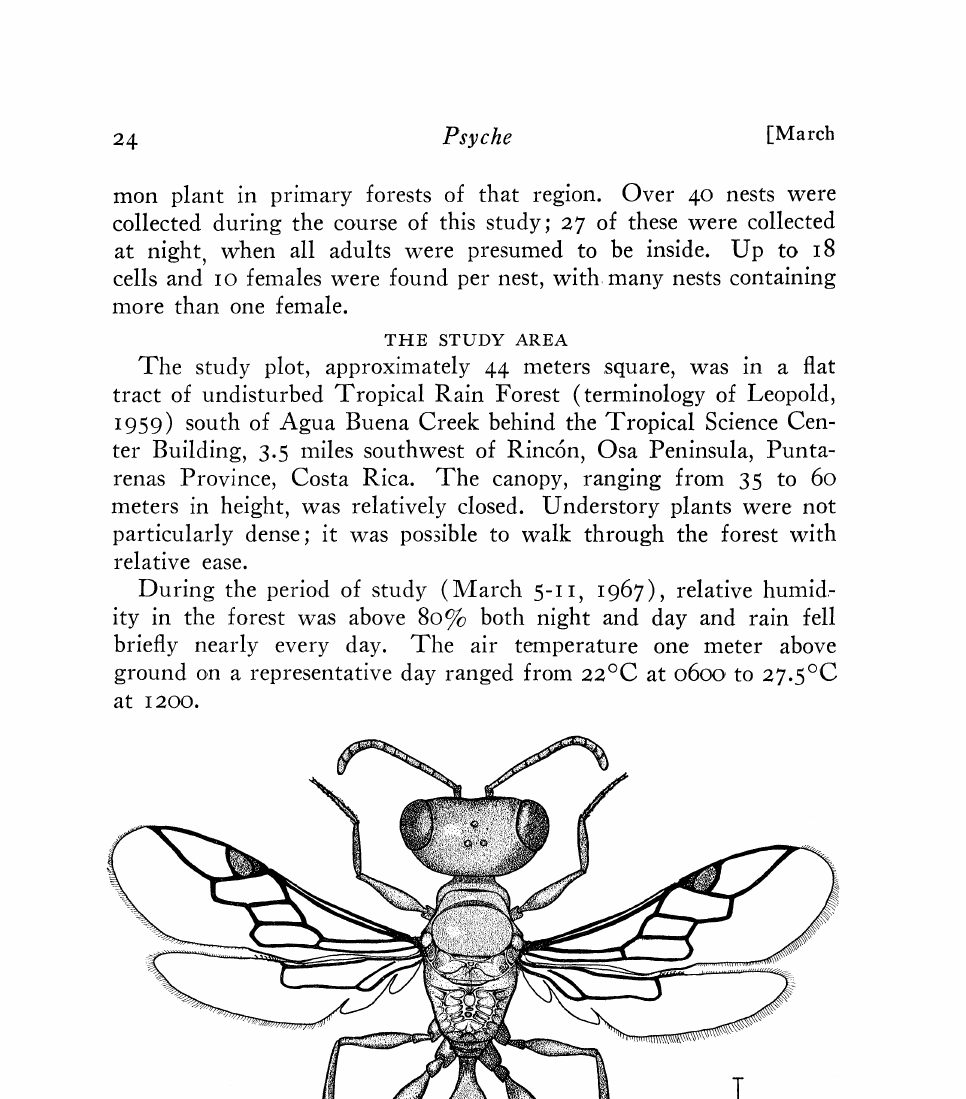
Fig. 1. Female of Microstilmus comes